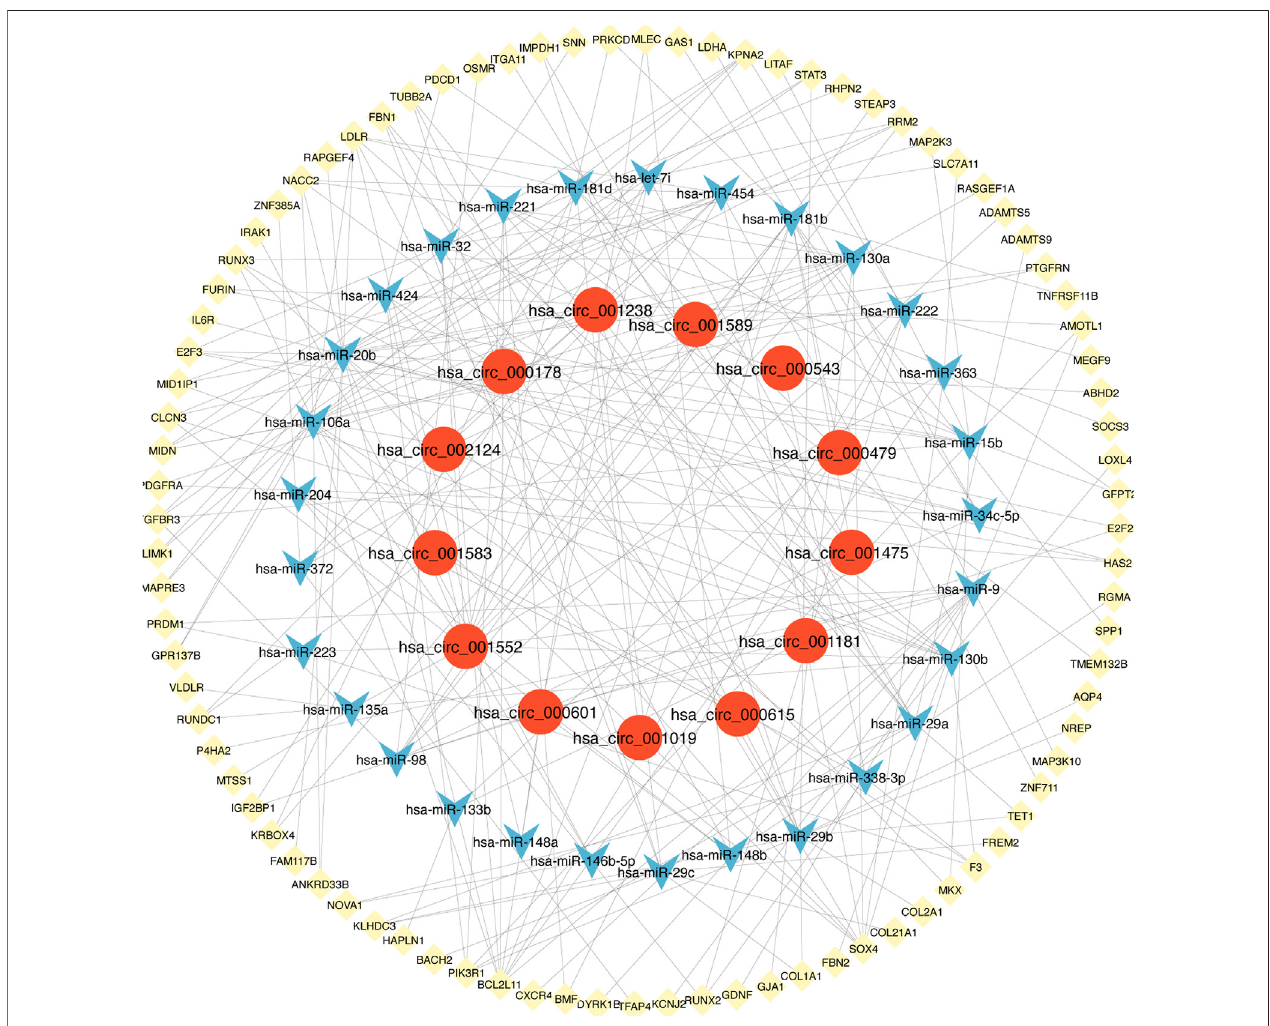
FIGURE 6 | The view of DEcircRNA-DEmiRNA-DEmRNA regulatory network. The network includes 29 miRNAs, 13 circRNAs, 88 mRNAs and 231 edges. The yellow diamonds represented mRNA, the blue V shape represented miRNA, and the red circles represented circRNA.